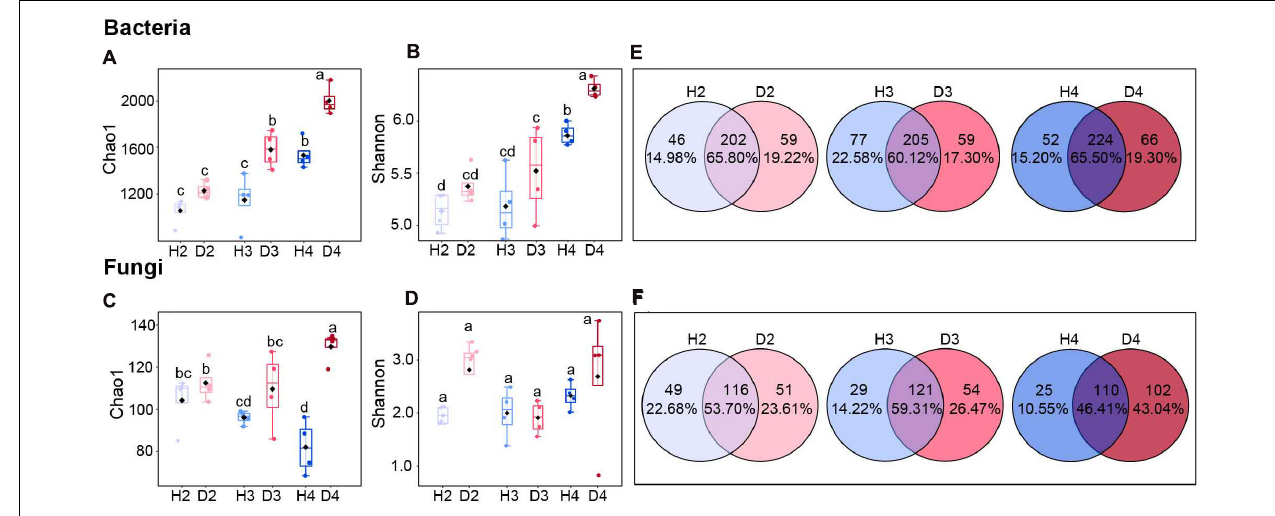
FIGURE 1 | Chao1 and Shannon indices of bacterial (A,B) and fungal (C,D) communities. Different letters above the bars indicate significant differences among samples. Significant differences between sample groups were determined by one-way ANOVA followed by Duncan’s multiple range test, P < 0.05; Venn diagrams of bacteria (E) and fungi (F) at the genus level in soils obtained from different aged healthy and diseased AG plants. H2, soils obtained from 2-year-old healthy AG plants; D2, soils obtained from 2-year-old diseased AG plants; H3, soils obtained from 3-year-old healthy AG plants; D3, soils obtained from 3-year-old diseased AG plants; H4, soils obtained from 4-year-old healthy AG plants; D4, soils obtained from 4-year-old diseased AG plants.